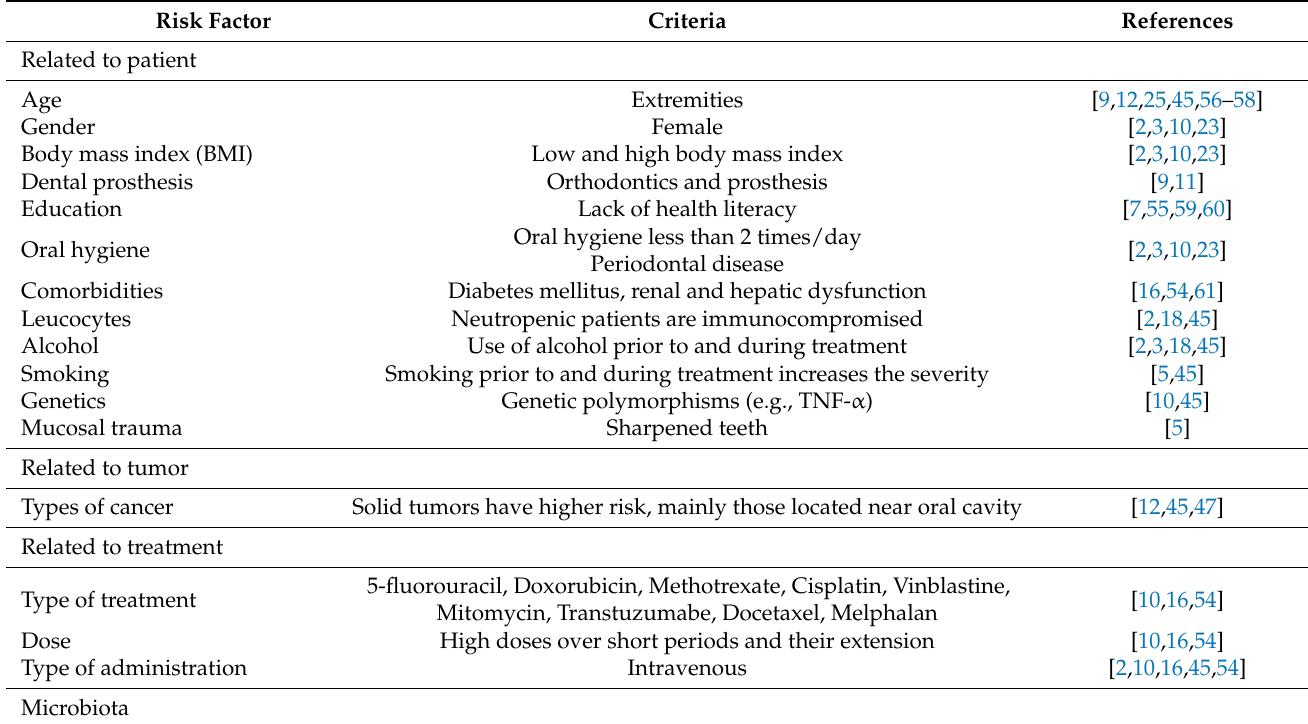
Table 2. Risk factors related to patients, tumors, and treatments in the development of oral